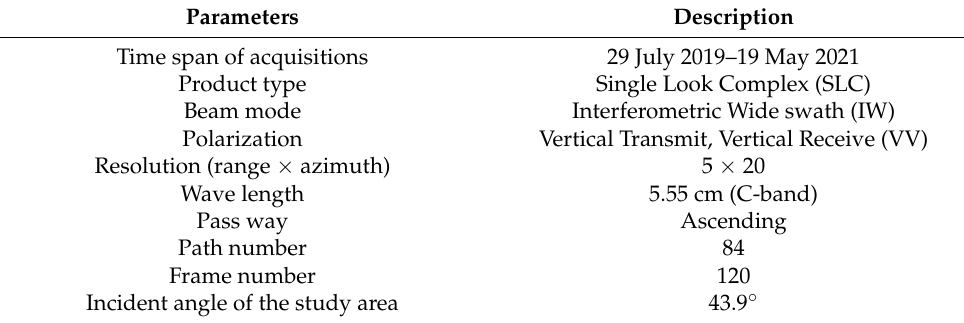
Table 2. Main parameters of Sentinel-1A SAR images over the Yingpanhao mine area, China.